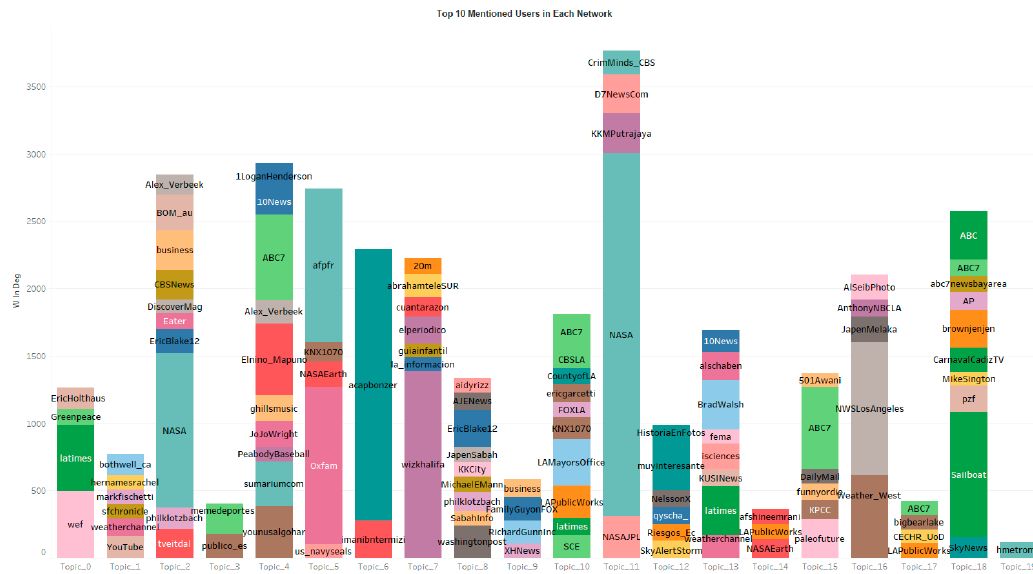
Figure 7. The top 10 mentioned users.